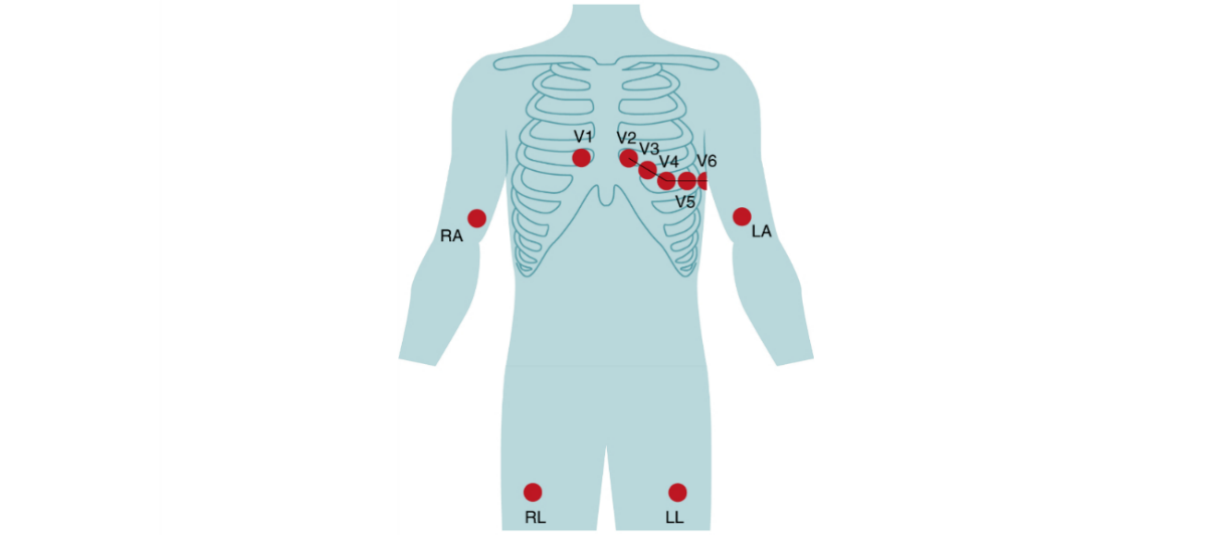
Figure 1. Placement of the electrodes of the standard 12-lead electrocardiographic system; LA: left arm; LL: left leg; RA: right arm; RL: right leg; V1 to V6: the 6 precordial